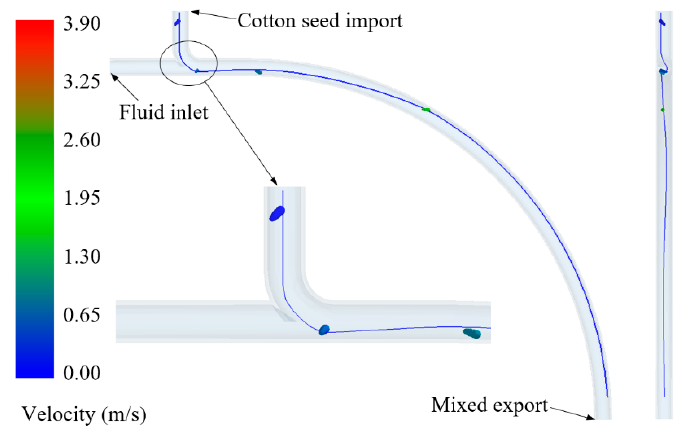
Figure 8. Simulation of the transport of cotton seed